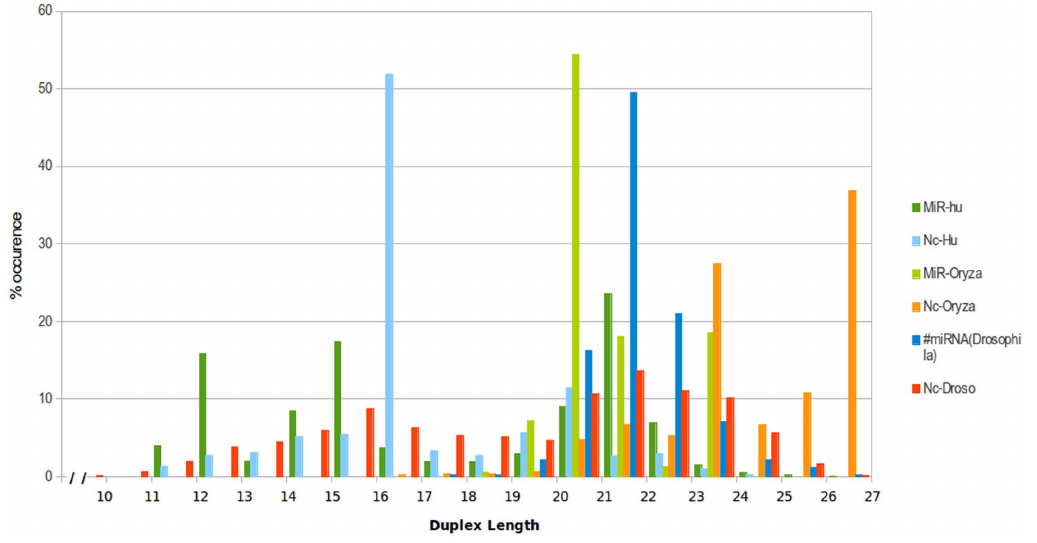
Figure 2. Length distribution for reads assemblies for miRNAs and non-miRNAs (ncRNAs). The assemblies from reads mapping to miRNAs had different length distributions than those observed for assemblies from reads mapping to other non-coding RNAs.